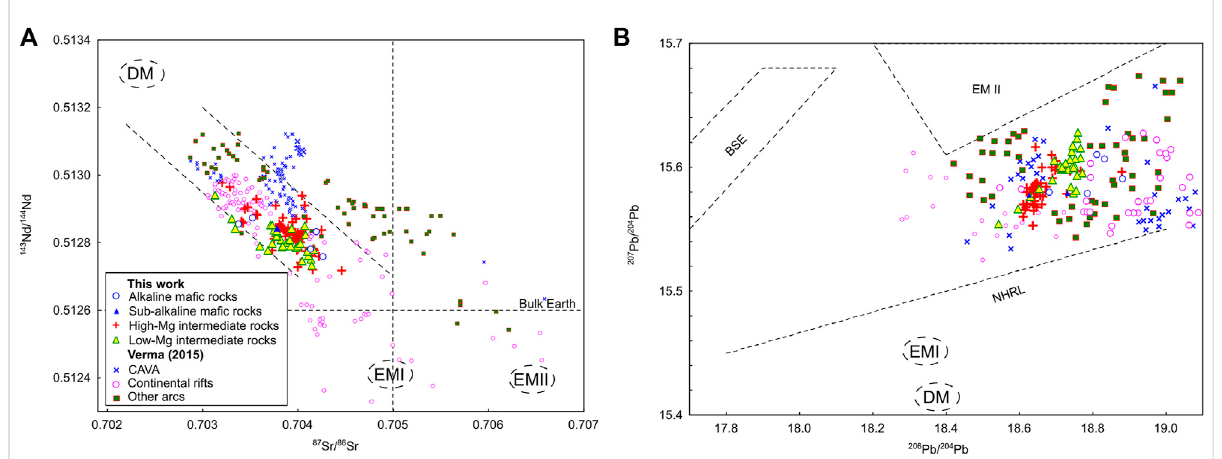
FIGURE 5 (A) Sr – NdisotopeplotforvolcanicrocksfromMGVF. (B) Pb – PbisotopediagramforvolcanicrocksfromMGVF.Abbreviations:BSE,bulksilicate Earth; EMII, enriched mantle type-II; and NHRL, Northern Hemisphere Reference Line. BSE and EMII are taken from Faure (1986), and NHRL values are from Zindle and Hart (1986). Data from Central American Volcanic Arc (CAVA), continental rifts (Abu, Gabra, China, East Africa, Ethiopia, Turkey (Kula), Basin and Range, Colorado Plateau, Rio Grande, and Utah), and other arcs (Aleutians, Fiji, Lesser Antilles, Mariana, Papua New Guinea, Philippines, and Sunda-Banda) are form the compilation made by Verma